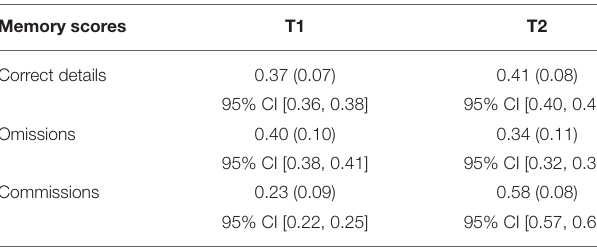
TABLE 4 | Mean proportions of the memory scores (i.e., correct details, omissions, commissions) reported during the first (T1) and the second (T2) memory test by